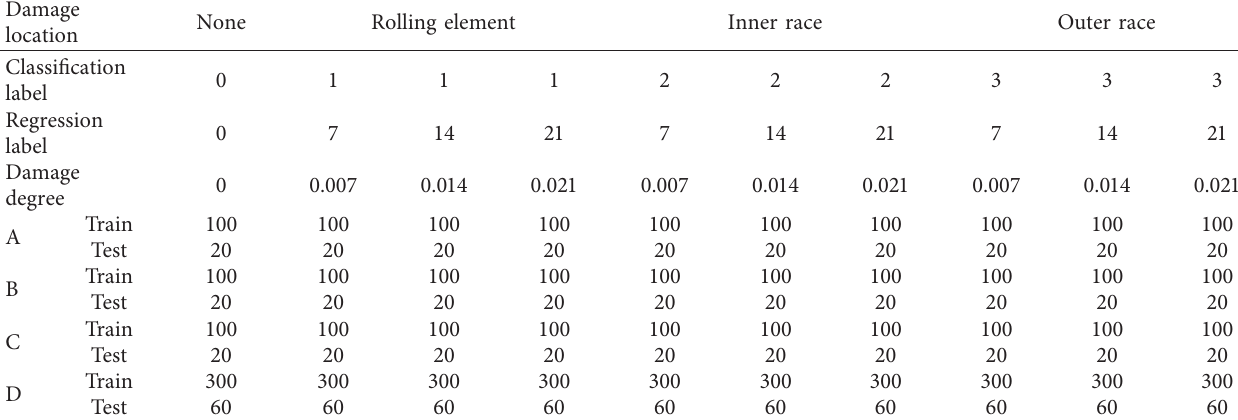
Table 1: Different data sets.